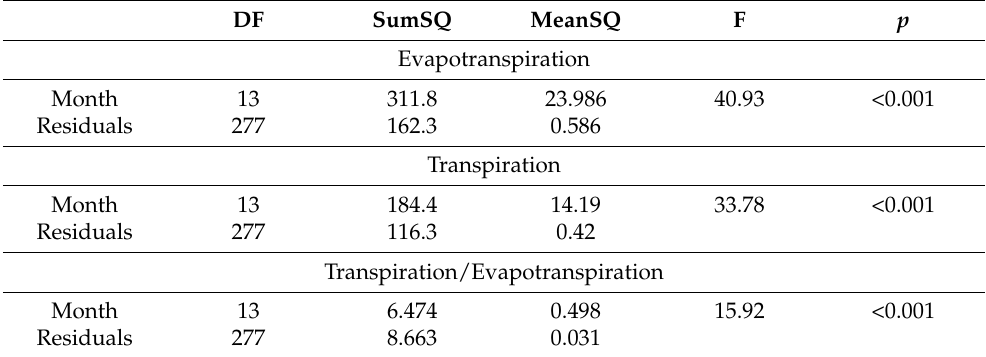
Table 2. Results of one-way ANOVA for statistical differences of transpiration, evapotranspiration, and transpiration to evapotranspiration ratio between the months.